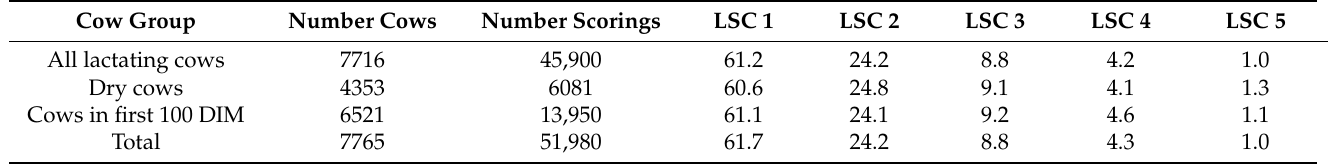
Table 1. Mean incidence risks (%) of locomotion scores (LSC 1–5) of 7765 cows from 99 dairy herds for 2020 grouped into all lactating cows, dry cows and cows during their first 100 DIM (days in milk) with a total of 51,981 locomotion records; LSC 1: non-lame; LSC 2: slightly lame; LSC 3: moderately lame; LSC 4: clearly lame; LSC5: severely